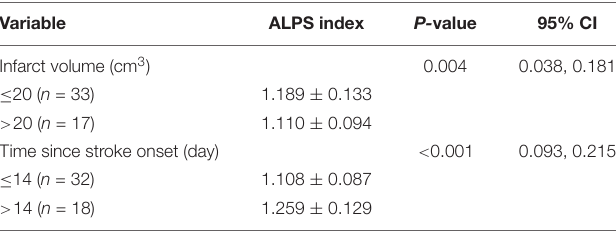
TABLE 3 | Group differences in ALPS index according to infarct volume and time since stroke onset.